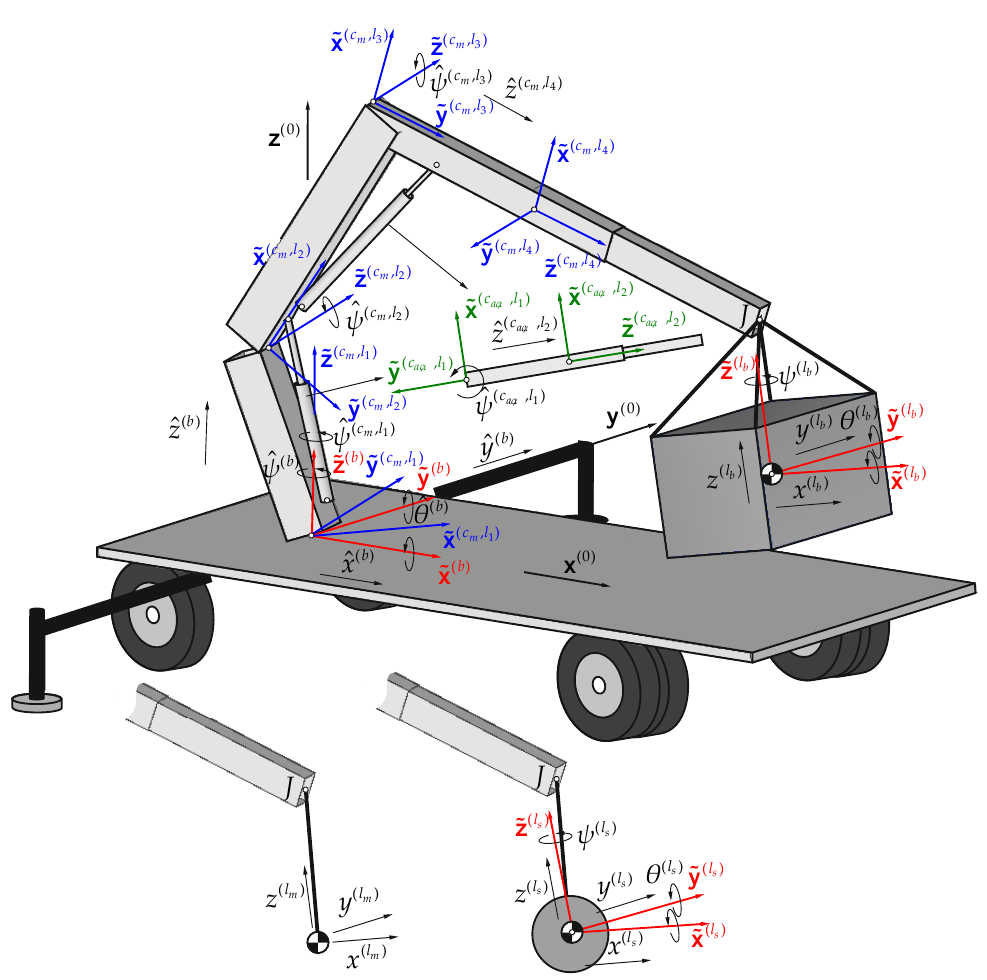
Figure 2. Description of the system — local frames of the links. Blue — main chain, green — auxiliary chains, red — flexible supported base and load.